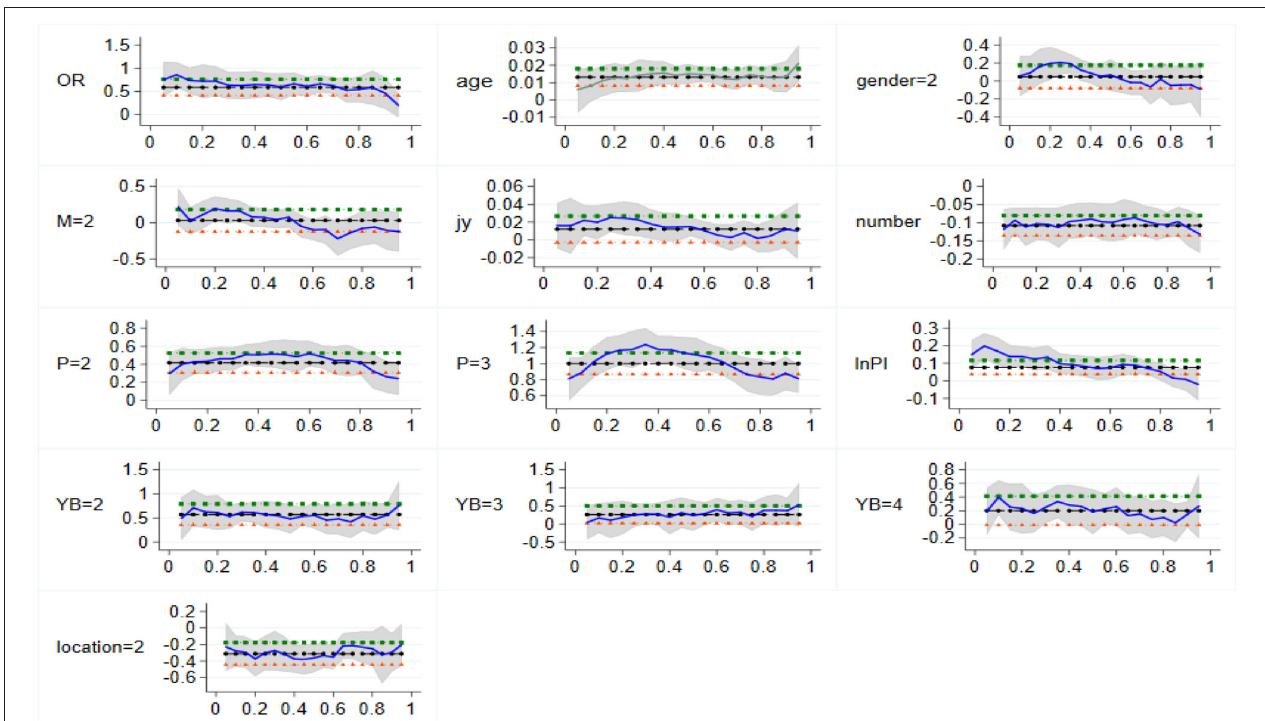
FIGURE 4 | Change of quantile regression coefficient in Western China. The vertical coordinate is the estimated value, whereas the horizontal coordinate is the different